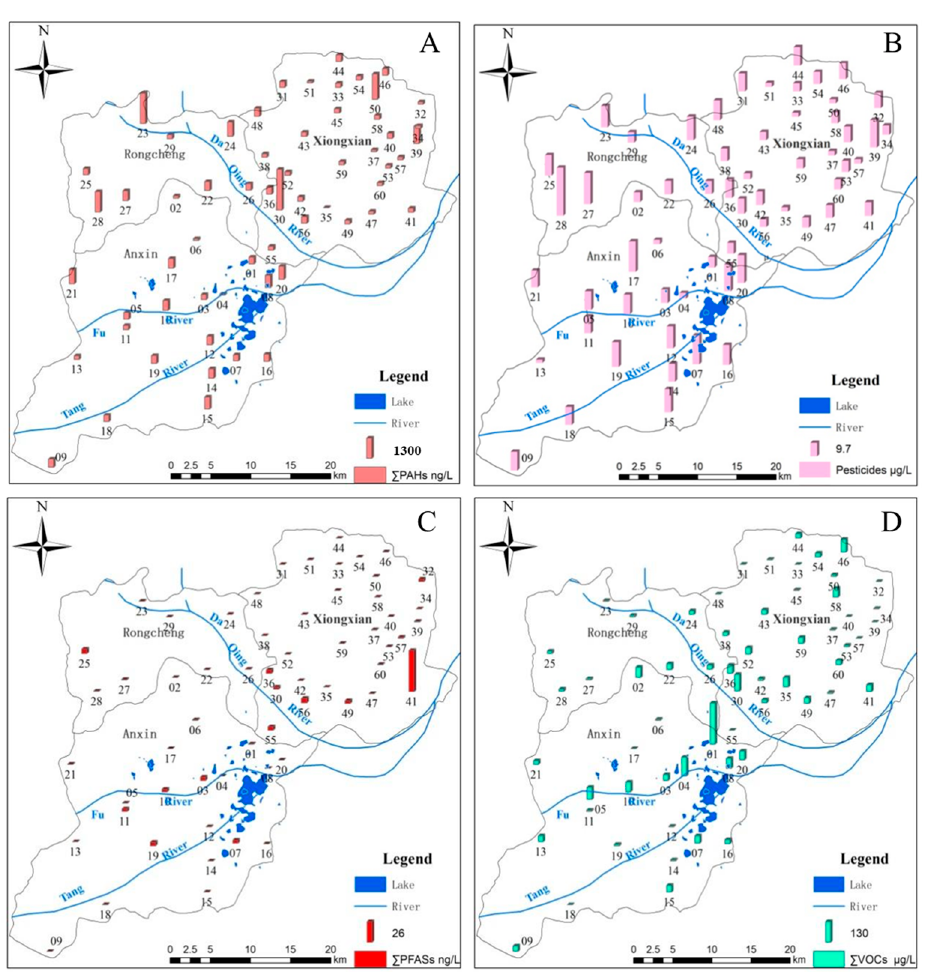
Figure 4. Distribution of PAHs, pesticides, PFASs and VOCs. ( A ) The distribution of PAHs; ( B ) The distribution of pesticides; ( C ) The distribution of PFASs; ( D ) The distribution of VOCs.